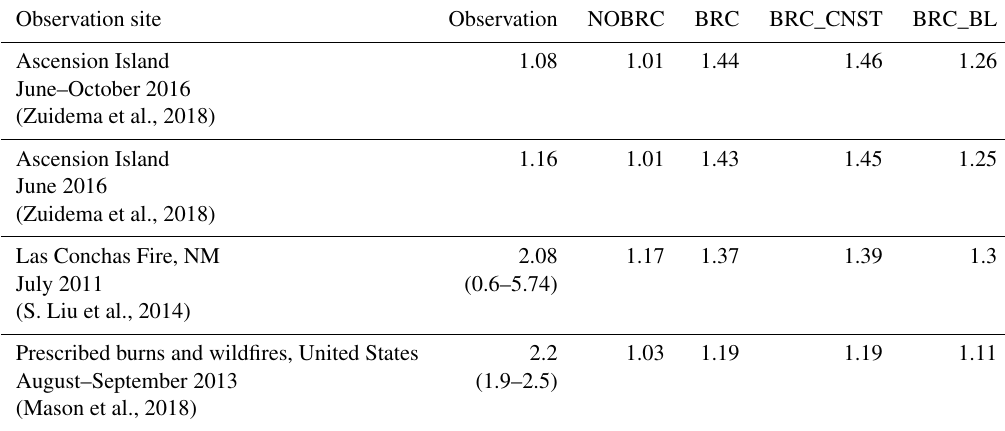
Figure 4. Absorption Ångström exponent (AAE) comparison between all of the AERONET sites from Fig. 3 and the four model runs: (a) NOBRC, (b) BRC, (c) BRC_CNST, and (d) BRC_BL. The lower row looks at the same model comparisons neglecting the Ascension Island site. Red indicates African sites, orange indicates South American sites, and blue indicates Arctic sites. The solid line indicates a 1 : 1 fit and the dotted line is a best fit to the data with the slope and correlation coefficient shown. Table 2. Comparisons between modeled AAE and the AAE from observations at Ascension Island during the LASIC (Layered Atlantic Smoke Interactions With Clouds (LASIC) campaign, the Las Conchas fire in New Mexico, and biomass burning and prescribed burns from the United States during SEAC 4 RS (Studies of Emissions and Atmospheric Composition, Clouds and Climate Coupling by Regional